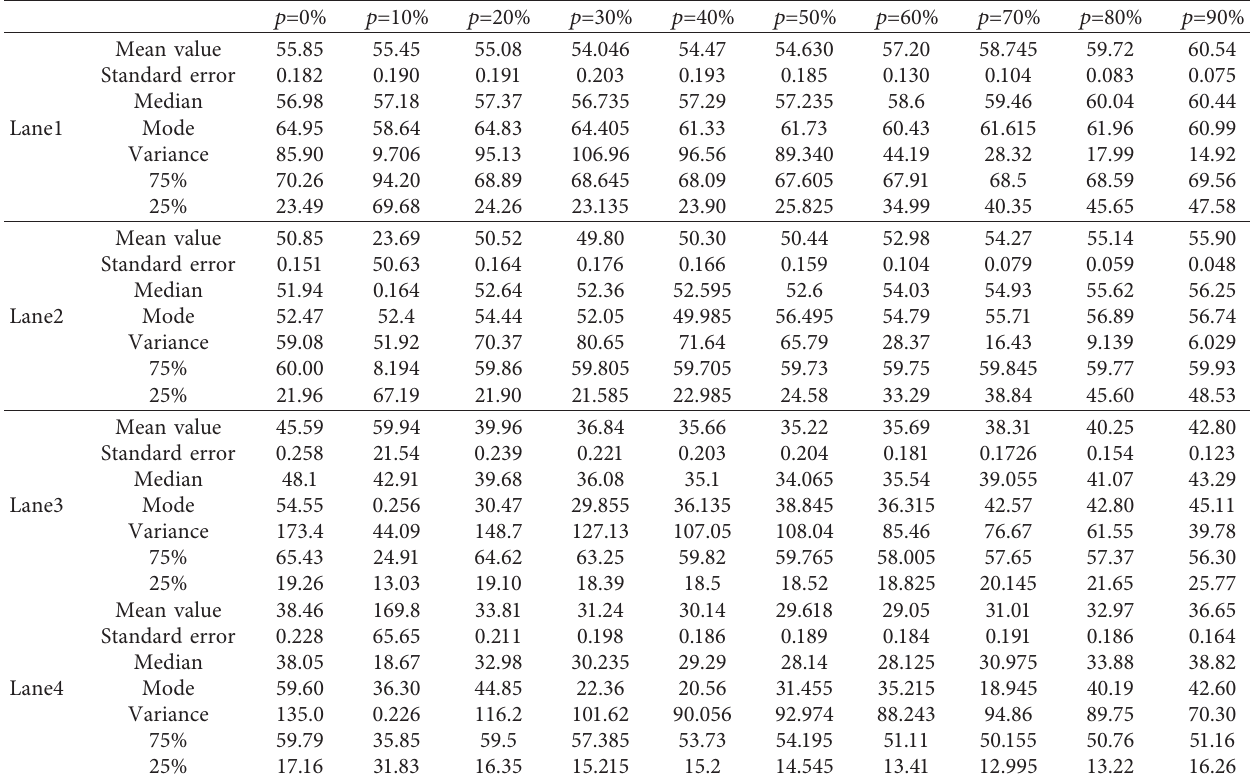
Table 2: The statistical description table of the speed of each lane under different autonomous vehicle penetration